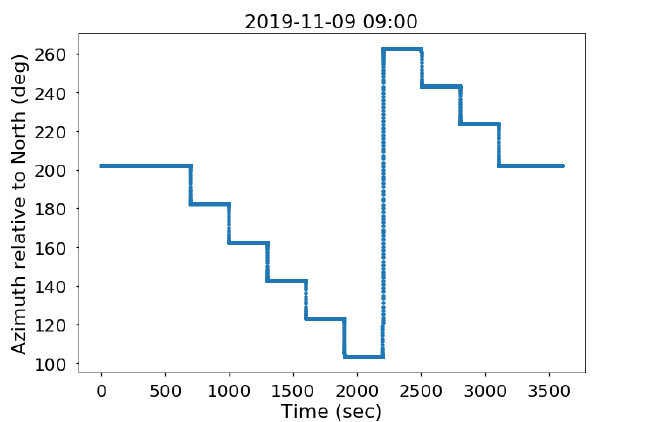
Figure 1. Example of the KaBODS nominal azimuth positions within one hour cycle. The data correspond to 9 November 2019, starting at 09:00 a.m. The time is shown as the time in seconds since the beginning of the cycle.